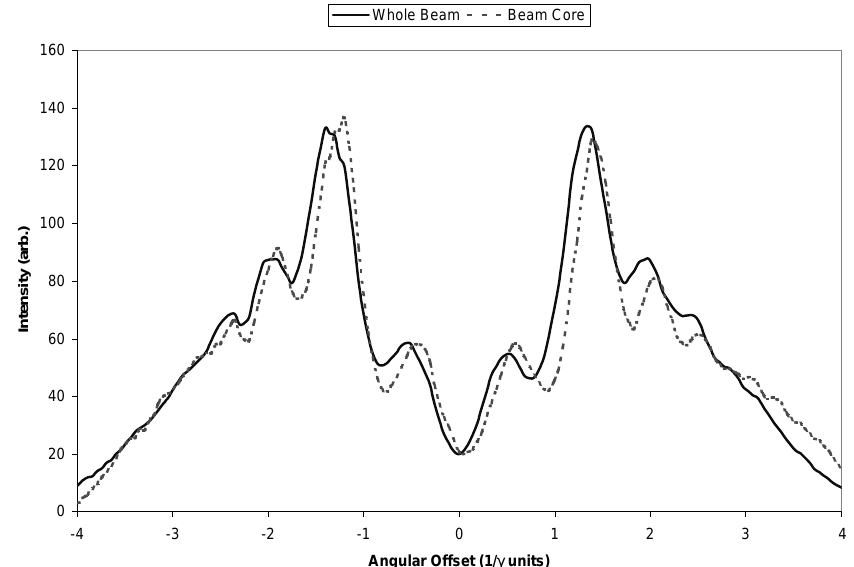
FIG. 6. Lineouts of whole-beam and beam-core vertically polarized OTRI.